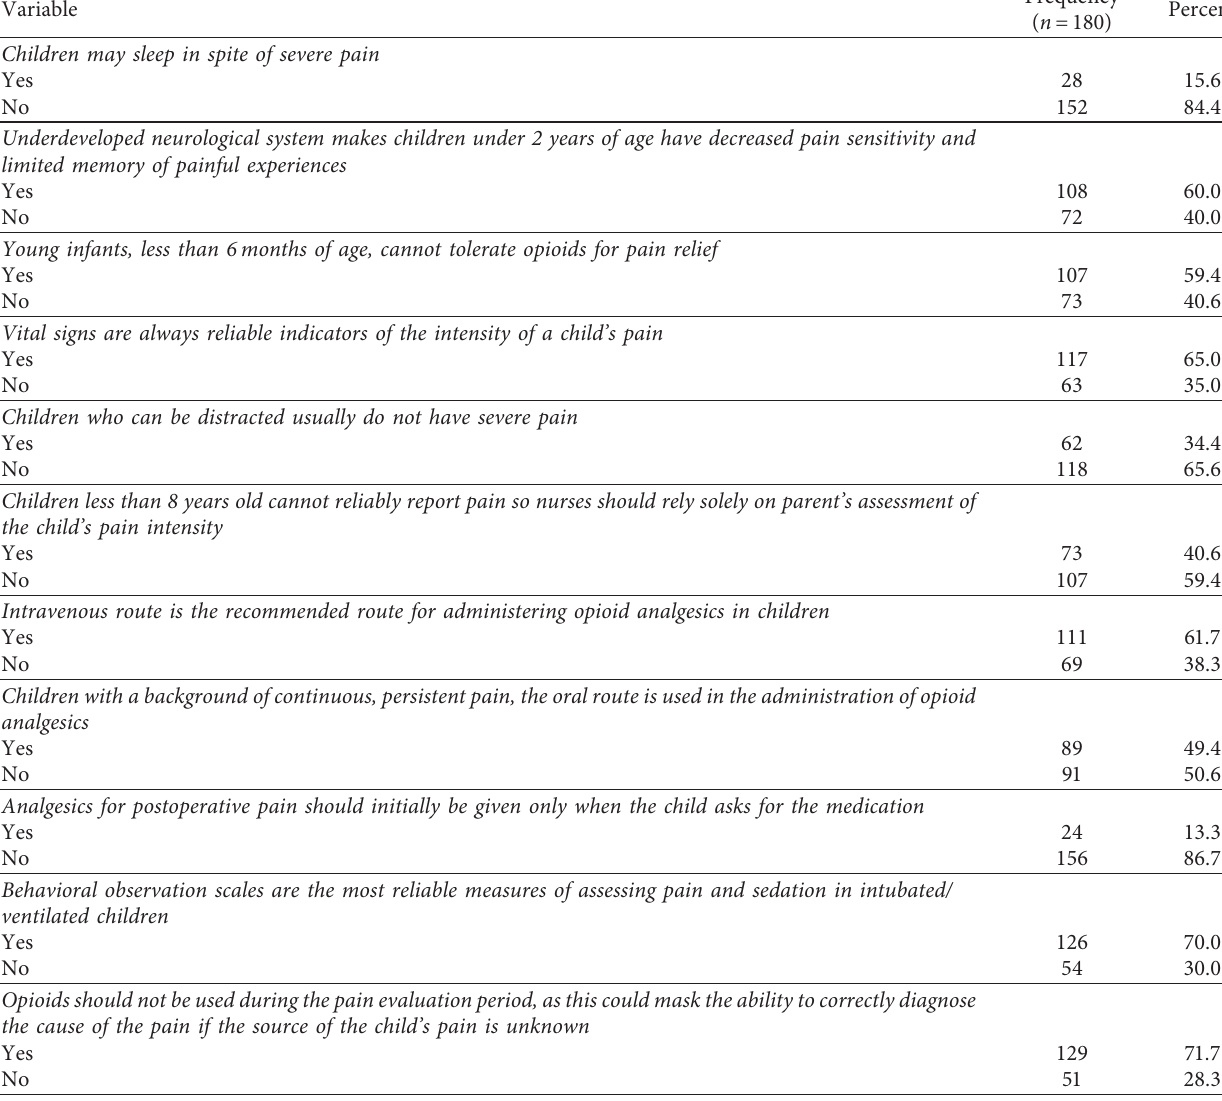
Table 2: Knowledge of paediatric pain management among